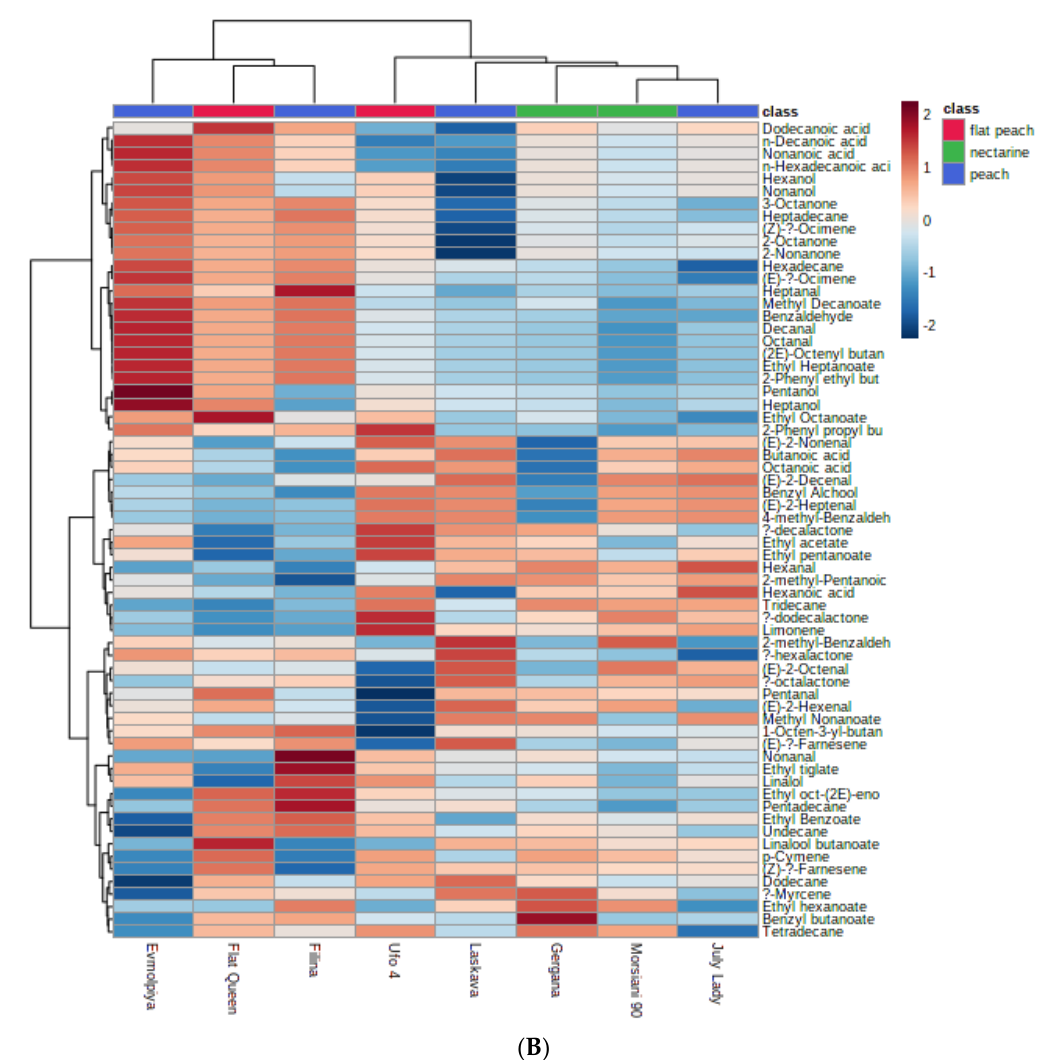
Figure 2. Clustering results for eight peach cultivars, shown as a heatmap: ( A )—WF, ( B )—FP. The color scale of the heatmap ranged from dark brown (value, +2) to dark blue (value, − 2). The values were normalized by log 10 transformation.